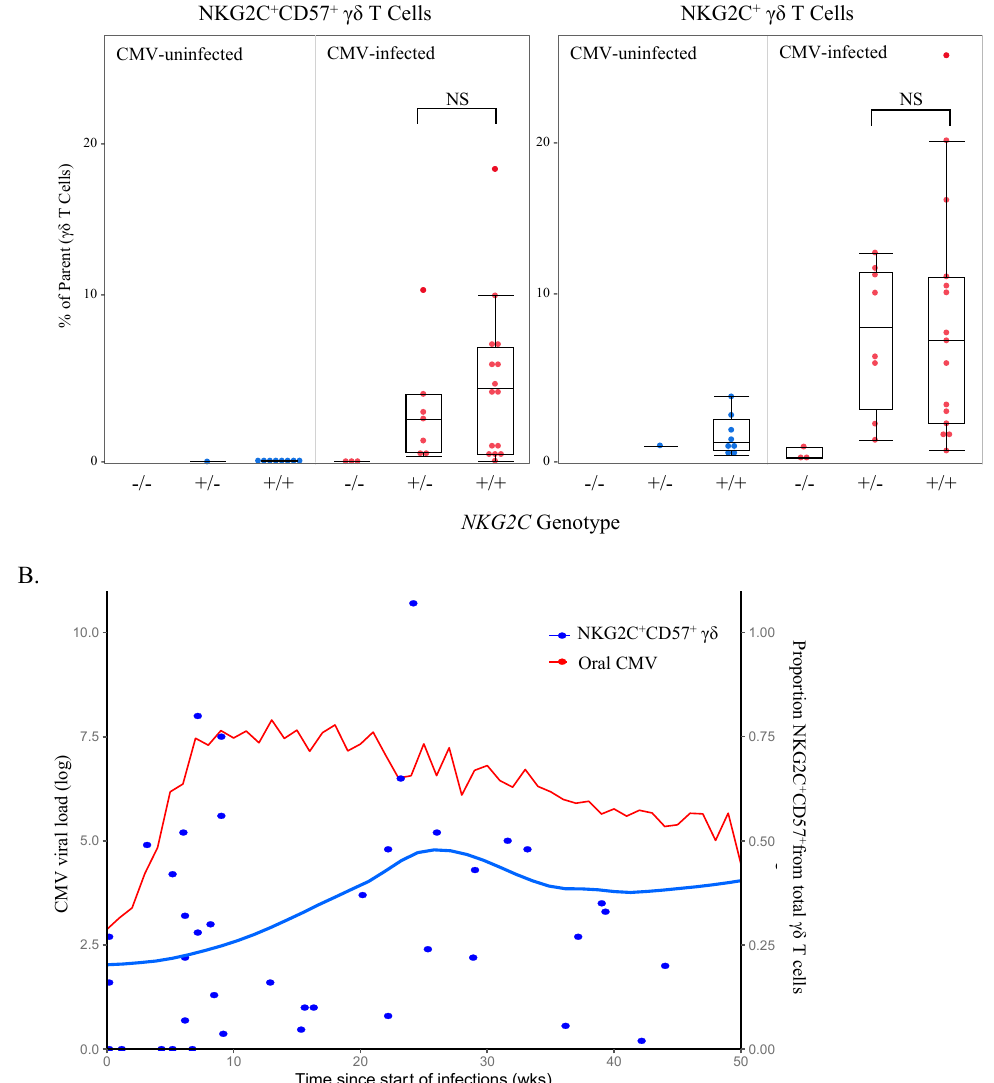
Figure 8. NKG2C + CD57 + γδ T cell frequency is associated with NKG2C genotype and oral CMV shedding. ( A ) Proportions of NKG2C + CD57 + and NKG2C + γδ T cells (gated from live total γδ T cells and acquired via spectral flow cytometry as shown in Figure 4A) were grouped by genotype and CMV status (infants n = 9, children n = 8 and adults n = 5). No samples from CMV-uninfected individuals who were homozygous for the NKG2C complete deletion were available for testing; NKG2C − / − n = 0, NKG2C − /+ n = 8, NKG2C +/+ n = 24. Statistical differences between NKG2C − /+ and NKG2C +/+ genotypes in CMV-infected individuals were determined using a Wilcoxon–Mann–Whitney test. Horizontal bars represent the median; boxes extend to the 25th and 75th percentile and whiskers represent the 95th percentiles; NS indicates not significant ( p -value > 0.05). ( B ) Weekly oral qPCR shedding (CMV log viral load) from CMV-infected Ugandan infants were concatenated and plotted from the date of primary infection. The red line indicates oral shedding in CMV-infected infants ( n = 20), measured by qPCR. The blue line ( n = 55) represents the mean of live γδ T cells that were CD57 + NKG2C + from the first conventional flow cytometry panel and was derived using LOESS smoothing function in R. The grey shading represents the standard error in the smoothed mean.